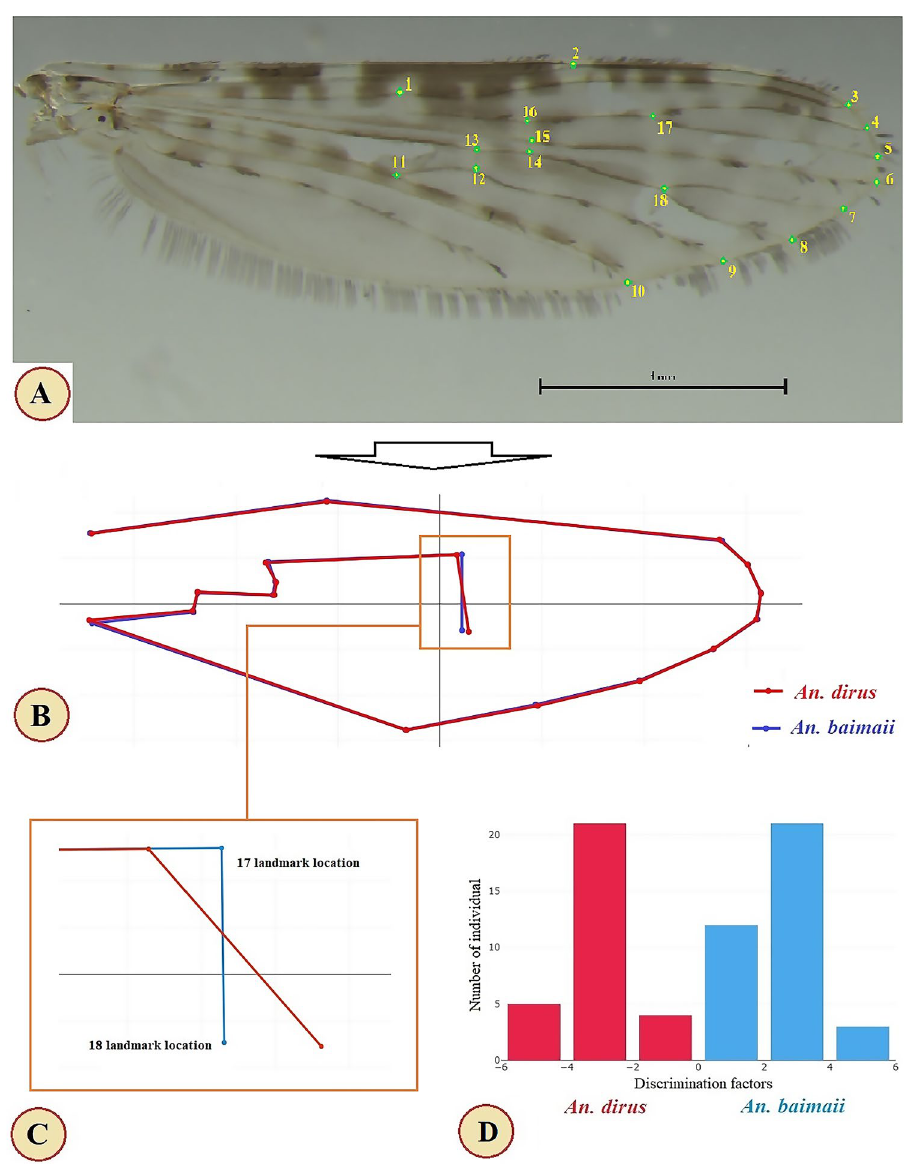
Figure 2. Location of 18 landmarks digitized on the right wing of a female Anopheles mosquito ( A ), superposition of the mean landmark configurations ( B ), mean superposition line formed by landmark coordinates at positions 17 and 18 ( C ), and factor map based on discriminant analysis between Anopheles dirus (red) and An. baimaii (blue)